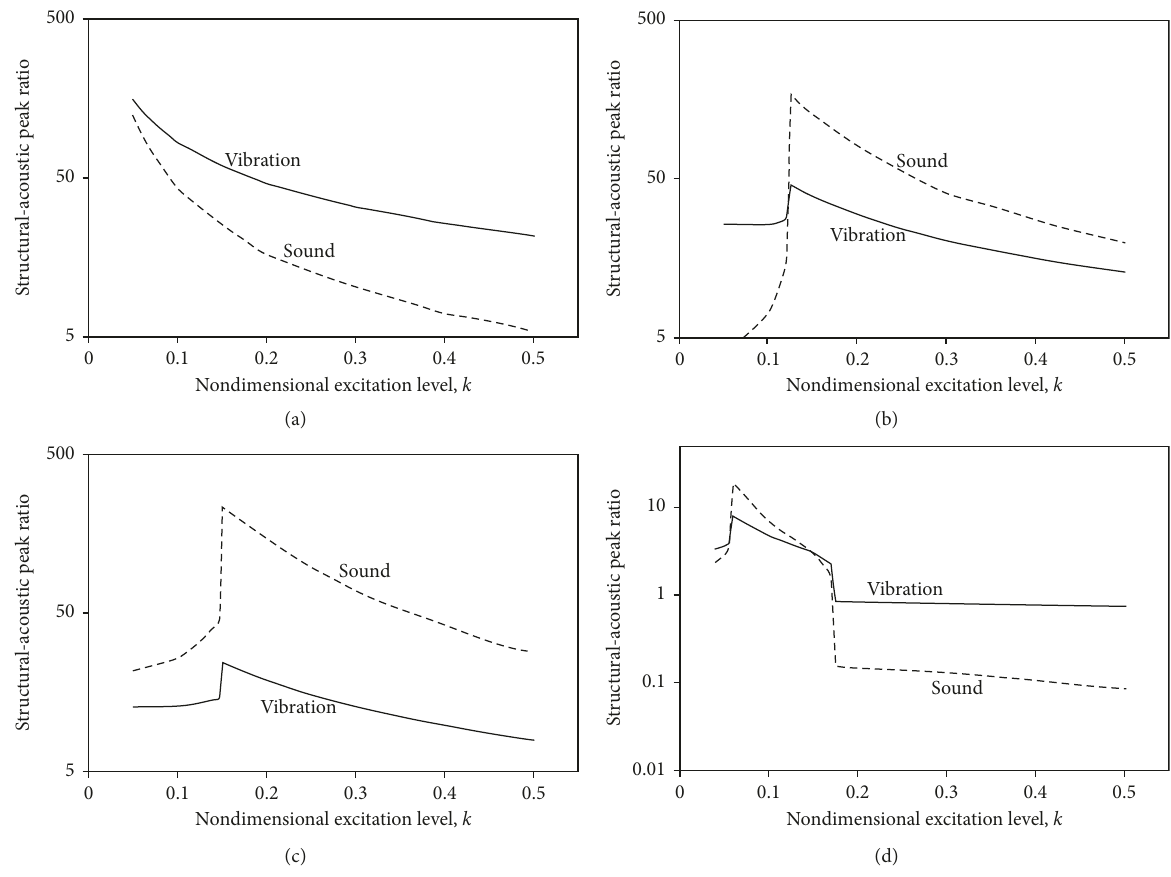
Figure 7: (a) (1,1) mode, (b) (2,1) mode, (c) (3,1) mode, and (d) (4,1) mode structural-acoustic peak ratios versus excitation level ( a b c 0.5m, ξ 0.02, and N (cid:31) (cid:31) (cid:31) (cid:31)